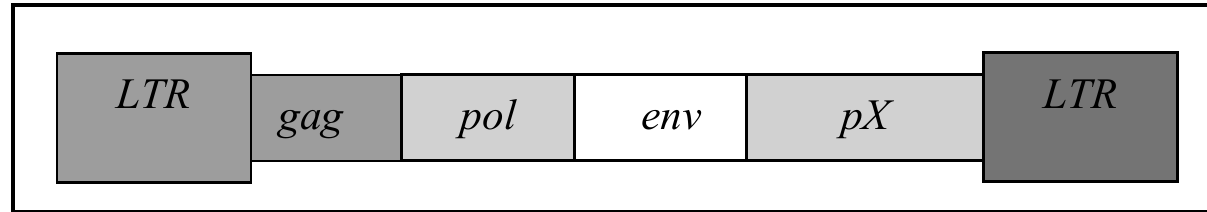
Figura 1 – Organização genética do vírus HTLV-I HTLV-I: vírus T-linfotrópico humano tipo I.